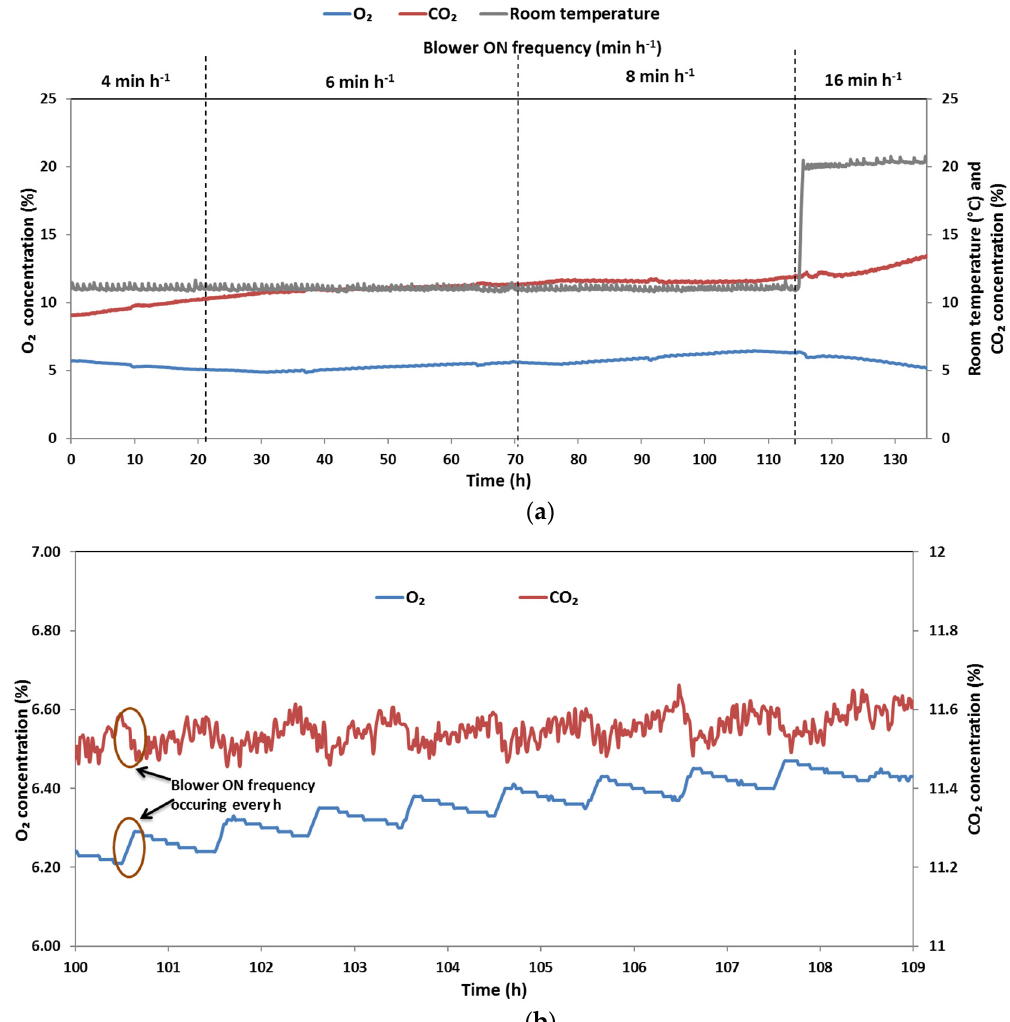
Figure 4. ( a ) Changes in the O 2 and CO 2 concentrations observed due to respiration of sweet cherries (25 kg) stored in a box (190 L) flushed with 6.5% O 2 and 12.5% CO 2 kept at 10 °C (until 114 h) and 20 °C (from 114 h to 135 h) and simultaneous active air flushing of the box achieved in real time through a tube (D: 4 mm, L: 250 mm) and a blower. ( b ) Closeup view of the gas concentration changes that occurred due to respiration of cherries (blower OFF) and forced air gas exchange (blower ON).